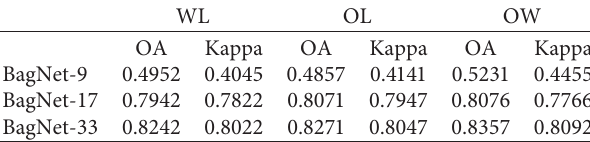
Table 2: Confusion matrix. Table 3: Accuracy comparison of different sizes of image Prediction